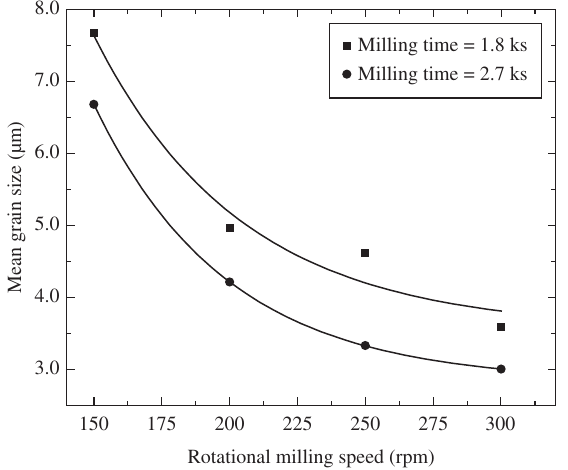
Figure 2. Variation of mean grain size with milling speed for 2.7 ks milling time.